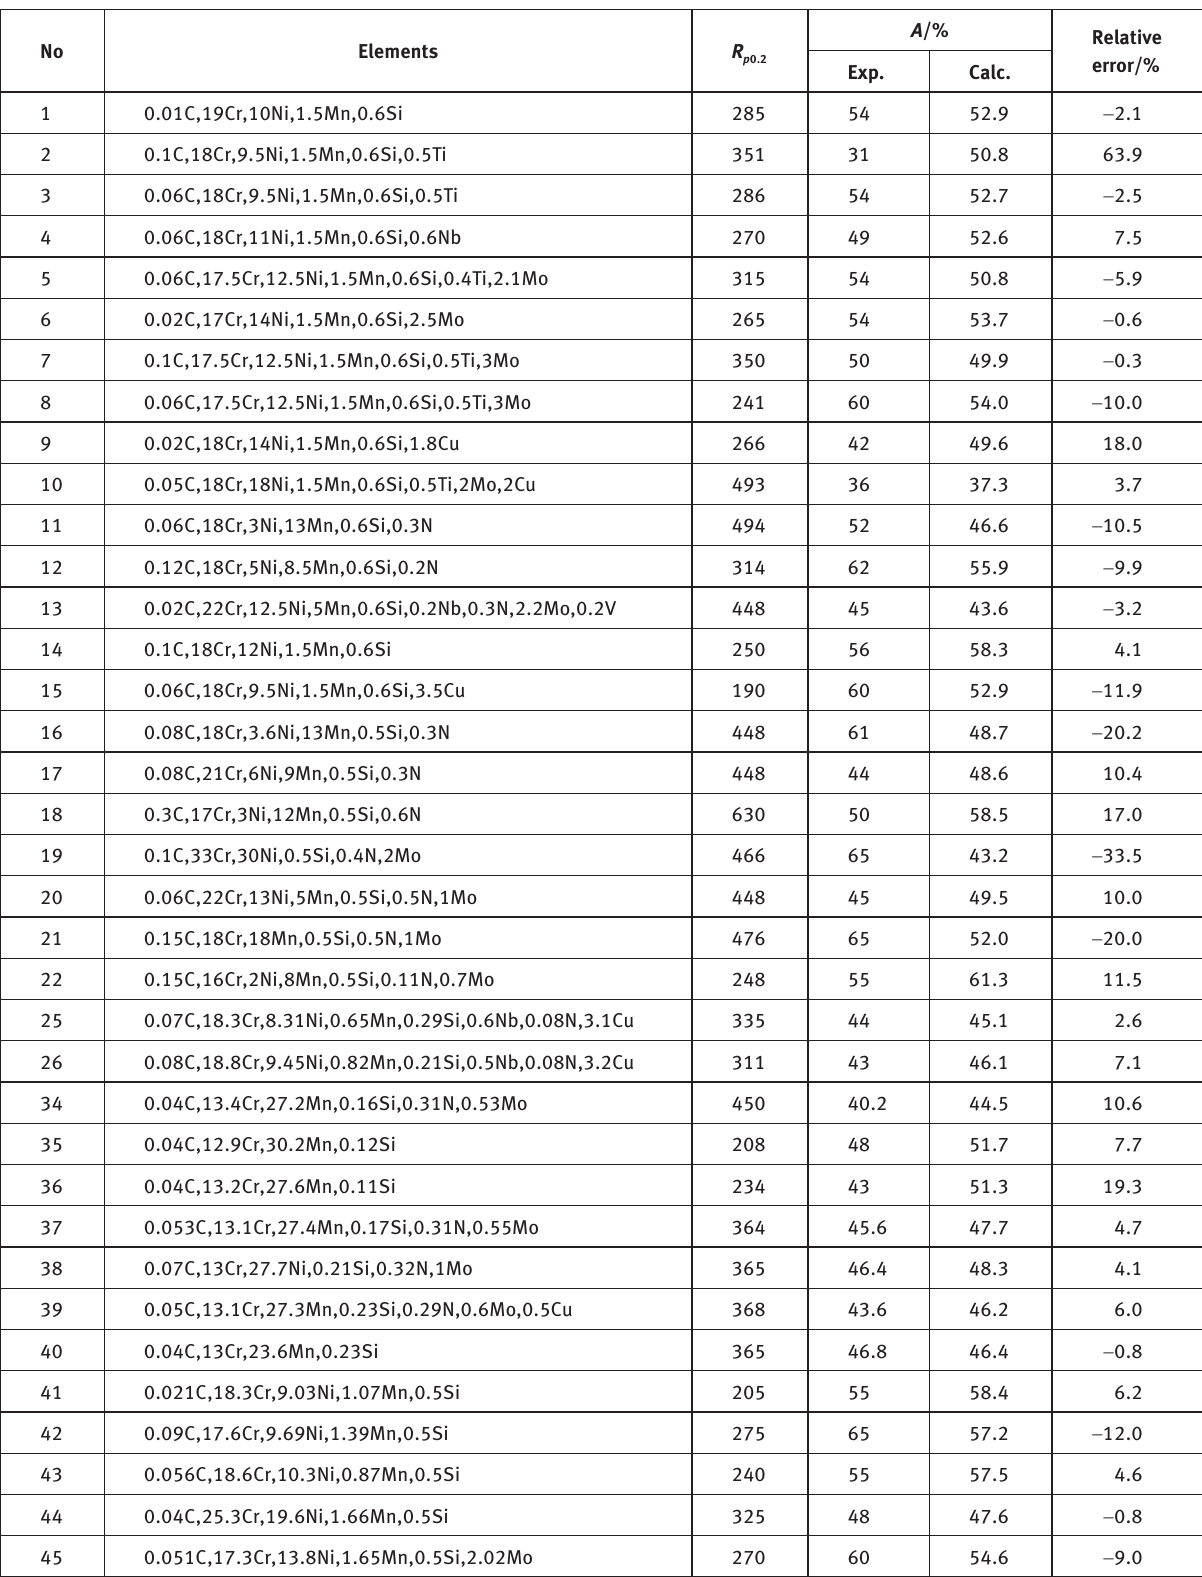
Table 1: Calculated value and test value of percentage elongation of the stainless